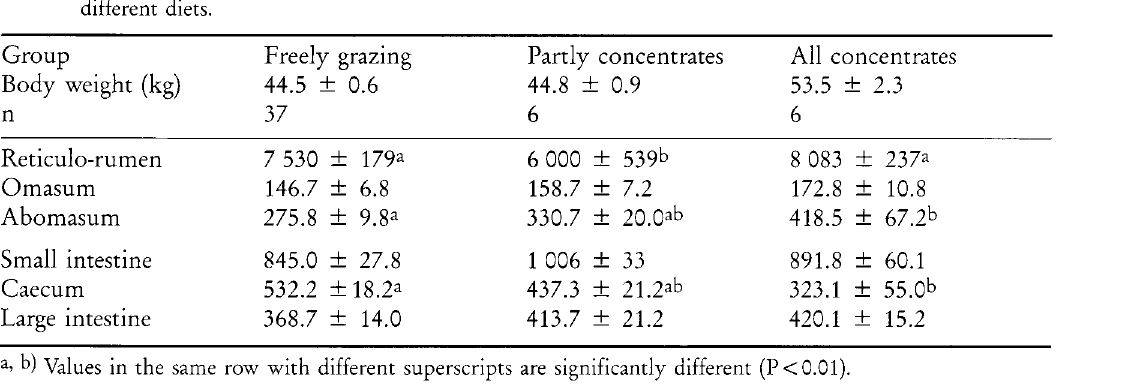
Table 1. Fresh weights with contents of regions (g, x ± S. E.) of gastrointestinal tract in reindeer calves fed three different diets.